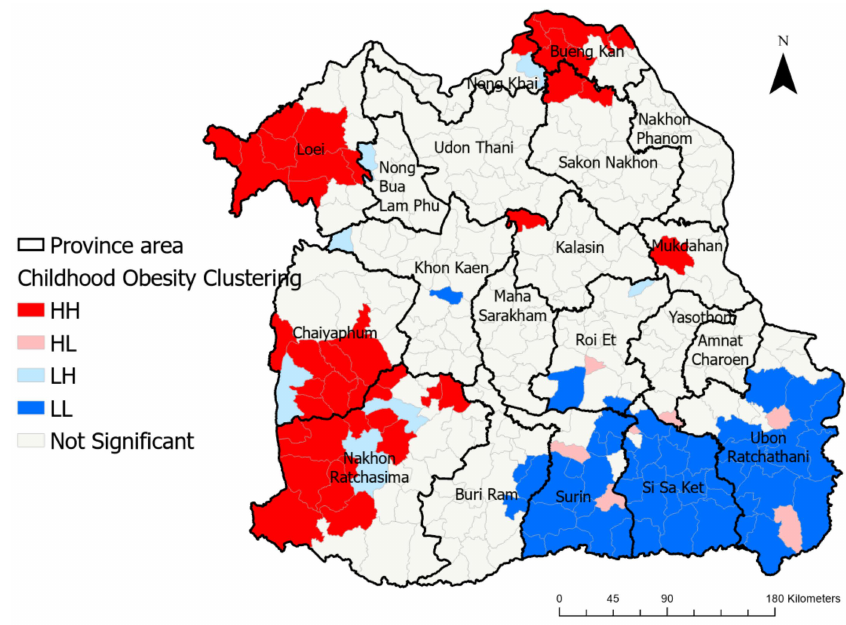
Figure 4. Clusters and outliners of childhood obesity across